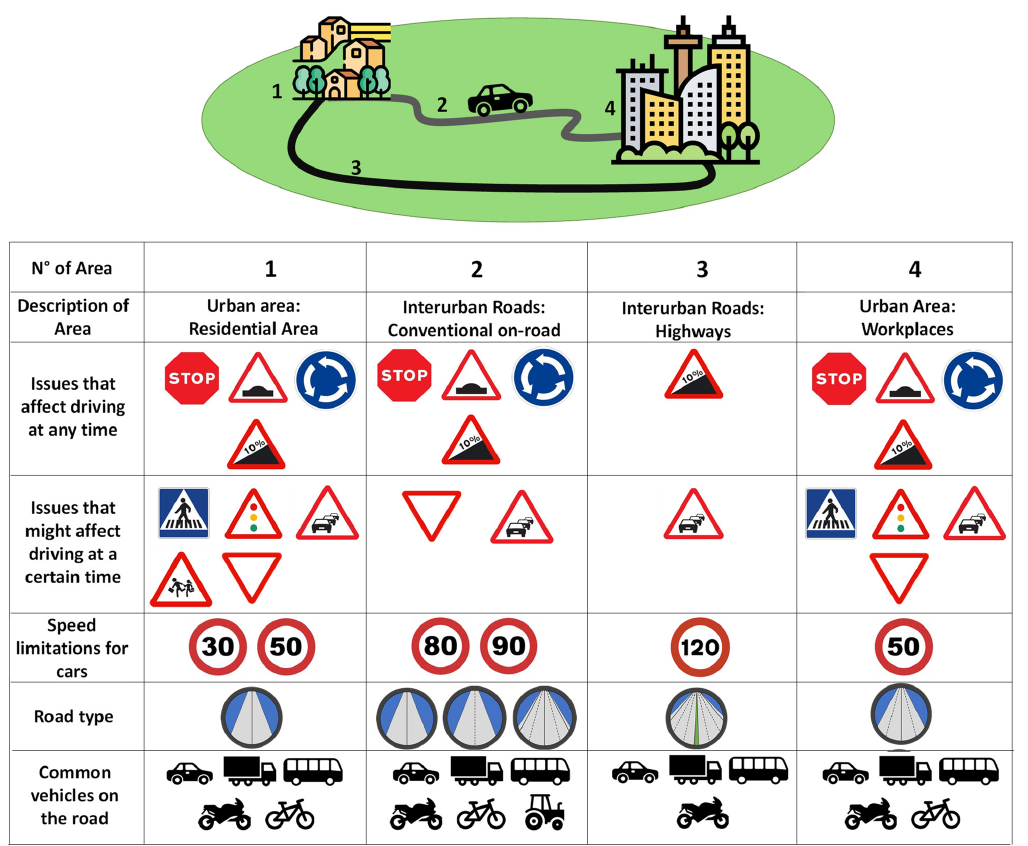
Figure 1. Identified areas and their characteristics affecting driver’s patterns.